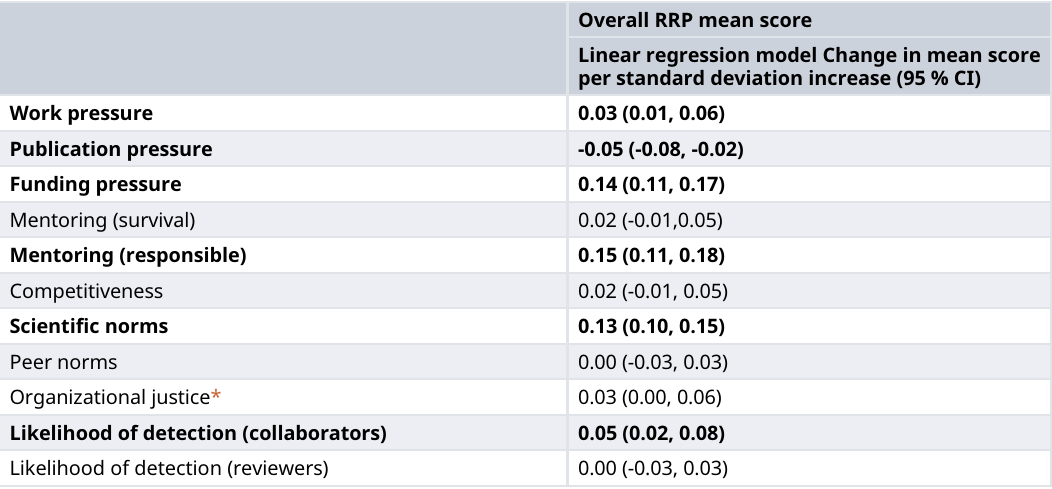
Table 2b. Linear regression coefficients (95% confidence intervals) of overall RRP mean score by explanatory factor